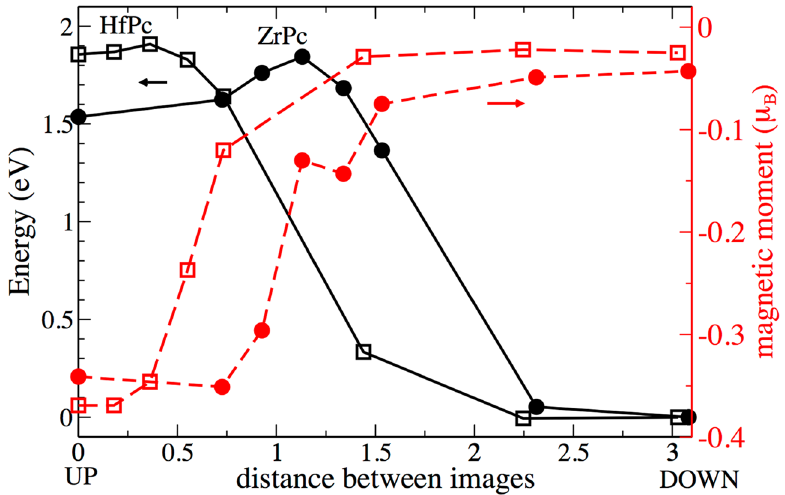
Figure 3. Energy barrier (black solid line) relative to the transition between the up - and down -configurations for HfPc (empty symbols) and ZrPc (full symbols) molecules on G/Ni(111) evaluated based on the NEB method. The magnetic moment of the Zr and Hf atoms are plotted with red dashed lines and referenced to the right axis. The distance between the images is defined as the root-mean-squared distances between all